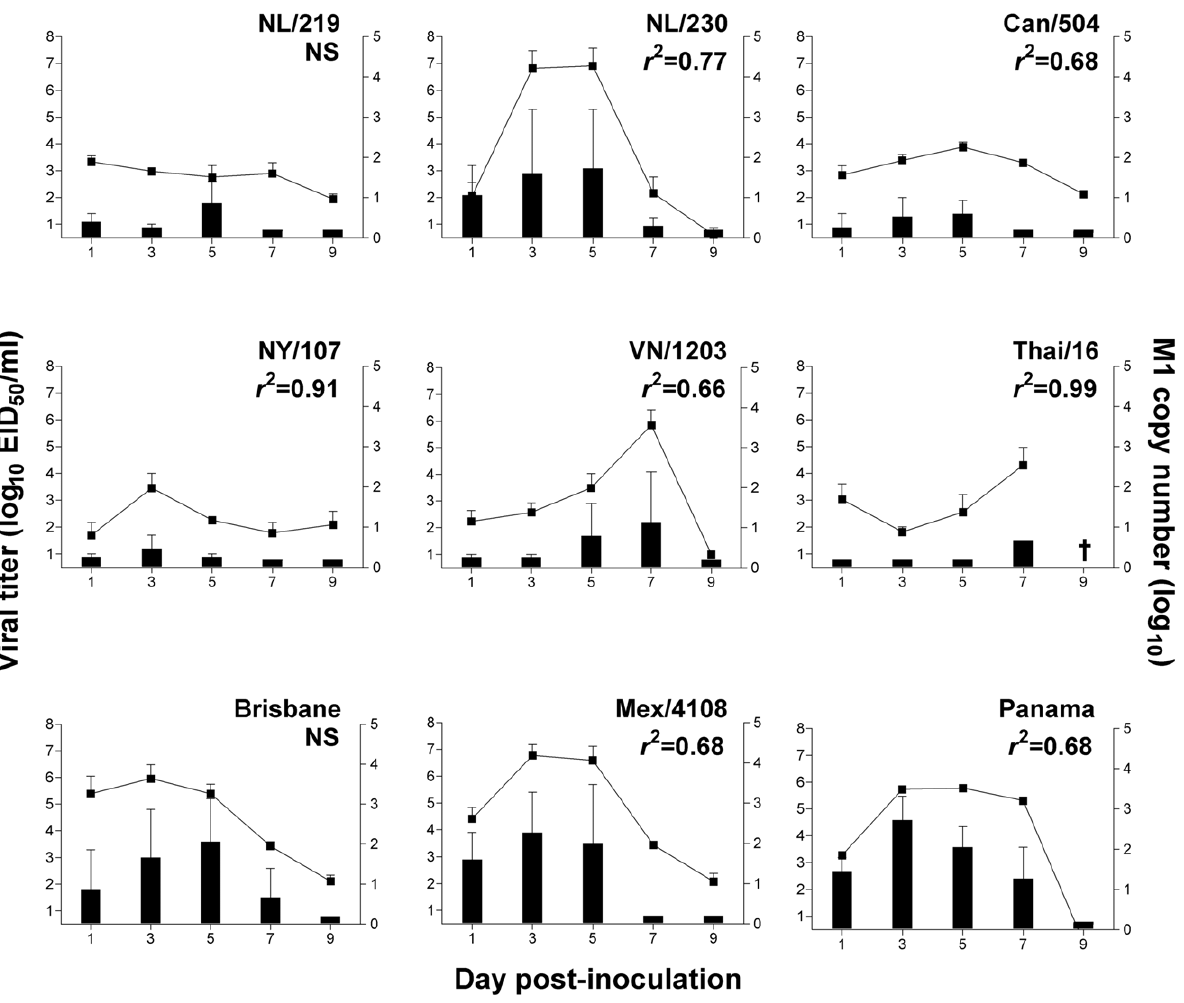
Figure 2. Comparison of influenza virus recovery in conjunctival wash samples following ocular inoculation of ferrets. Ferrets were inoculated by the ocular route with 10 6 EID 50 /ml of each virus shown. Viral titers were measured in conjunctival washes (CW) collected on indicated days following serial titration in eggs; endpoint titers are expressed as mean log 10 EID 50 /ml plus standard deviation (left y-axis and bars). Relative viral RNA copy number in conjunctival washes was determined by real-time PCR using a universal M1 primer and extrapolated using a standard curve based on samples of known virus (right y-axis and lines). The limit of virus detection was 10 1.5 EID 50 /ml. { , no ferrets survived until day 9 p.i. R-squared values are shown for those viruses where a statistically significant (p , 0.05) correlation between viral titer and viral RNA copy number exists. NS, not significant.